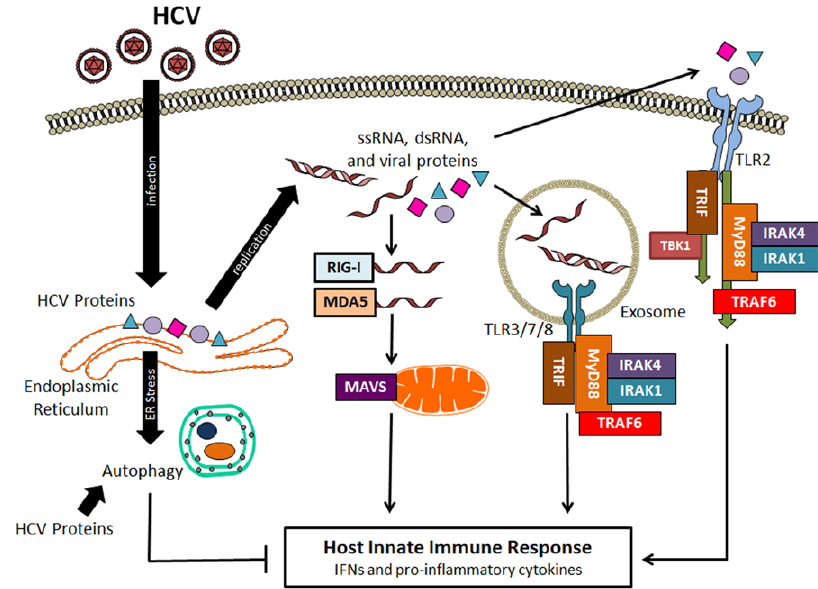
Figure 1. Hepatitis C virus (HCV) recognition by the host and HCV-induced autophagy. After infection, HCV genomic RNA and other HCV products such as double-stranded RNA (dsRNA) replication intermediates and viral proteins can activate retinoic acid-inducible gene I (RIG-I), melanoma differentiation-associated protein 5 (MDA5) and Toll-like receptors (TLRs) to activate signaling pathways to produce interferons (IFNs) and pro-inflammatory cytokines. HCV can also induce autophagy indirectly via the induction of endoplasmic reticulum (ER) stress or directly via its